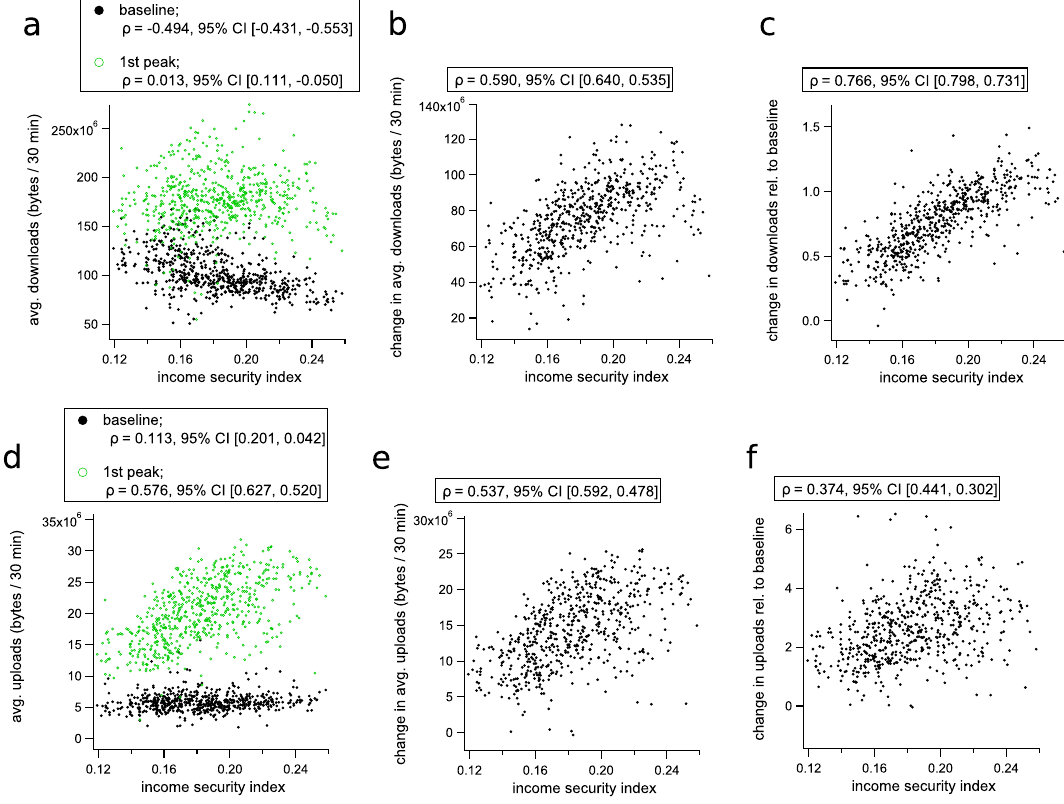
Figure 5. Changes to internet use during the 1st wave of COVID-19 restrictions in Australia, plotted against income security for each SA2 region. ( a ) Shows absolute average household download rates before (black dots) and during (green dots) the selected period (April 18th to April 24th, 2020). ( b ) Plots the absolute change in average per-household download rate during the first-wave period, and ( c ) plots the change in download rate relative to baseline. ( d ) Shows absolute upload rates before (black) and during (green) COVID-19, while ( e ) shows absolute changes to upload volume, and ( f ) shows changes to upload volume relative to baseline. In each subplot, the internet traffic quantifiers are plotted against the income security score for the corresponding SA2 region, and Pearson’s correlation coefficients with 95% CI intervals are shown in the